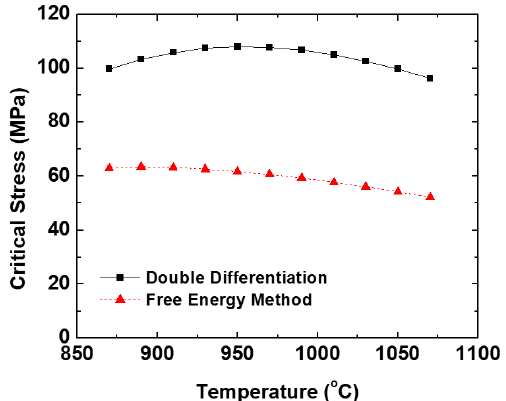
Figure 4. The calculated critical stresses using the free energy method (broken line) and the double differentiation method (solid line).